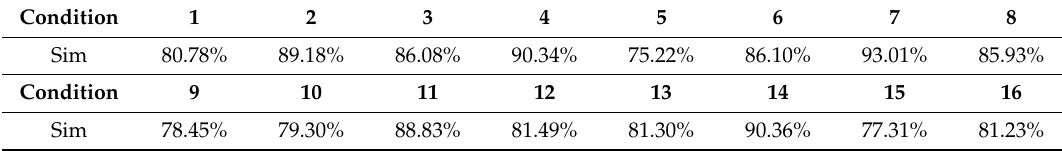
Table 2. Similar degree between subscale model and full-scale